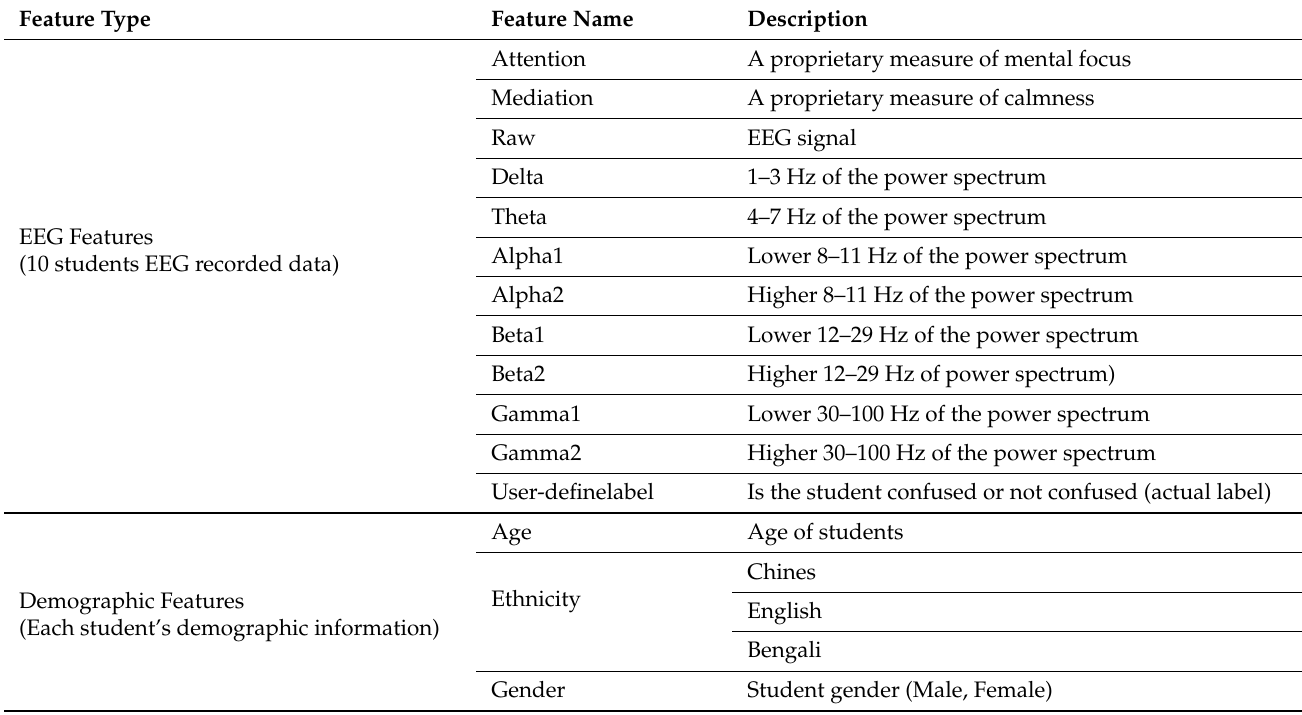
Table 3. Dataset features